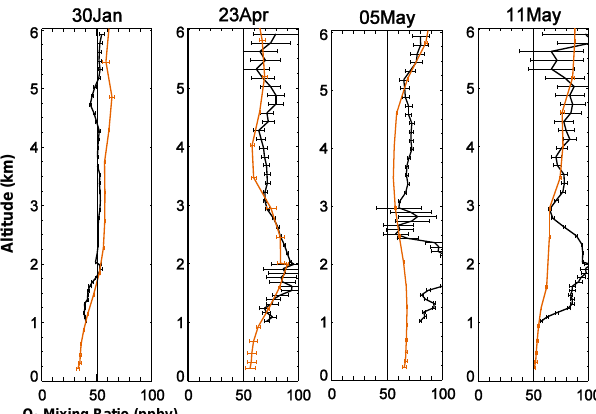
Figure 4. Vertical profiles of ozone volume mixing ratios over Saga measured by DIAL (black lines) and predicted by MRI-CCM2 (or- ange lines) on 30 January, 23 April, 5 and 11 May in 2012. The error bars shows the statistical errors calculated from the signal to noise ratios for the lidar and the standard deviation for the period predicted by